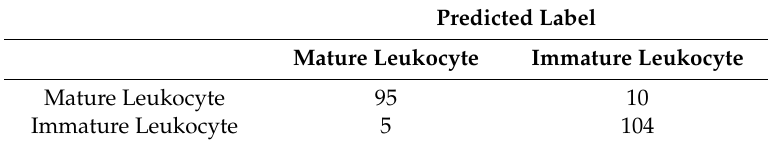
Table 4. Confusion matrix of the optimized model for binary classification on testing set.